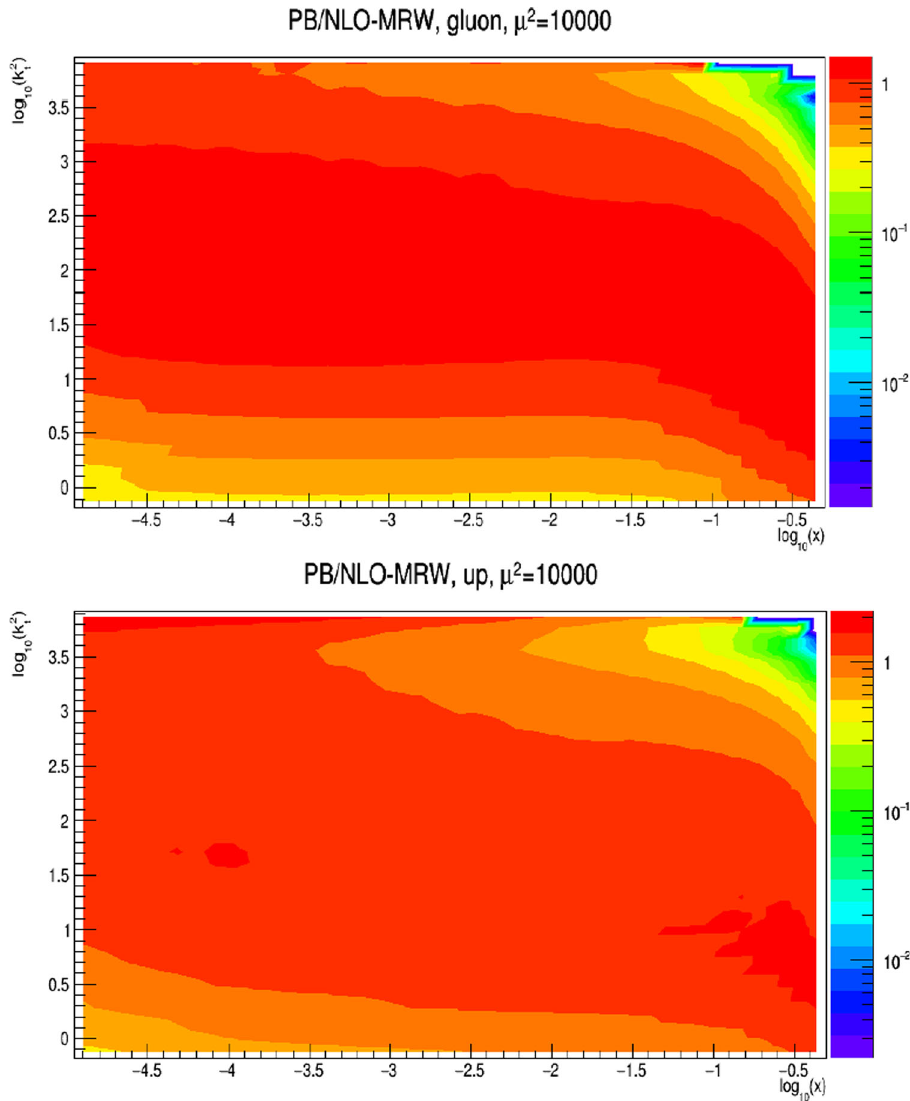
Fig. 4 The top (bottom) panel shows the fraction of NLO − MRW / PB for gluon (up) quark at μ 2 =